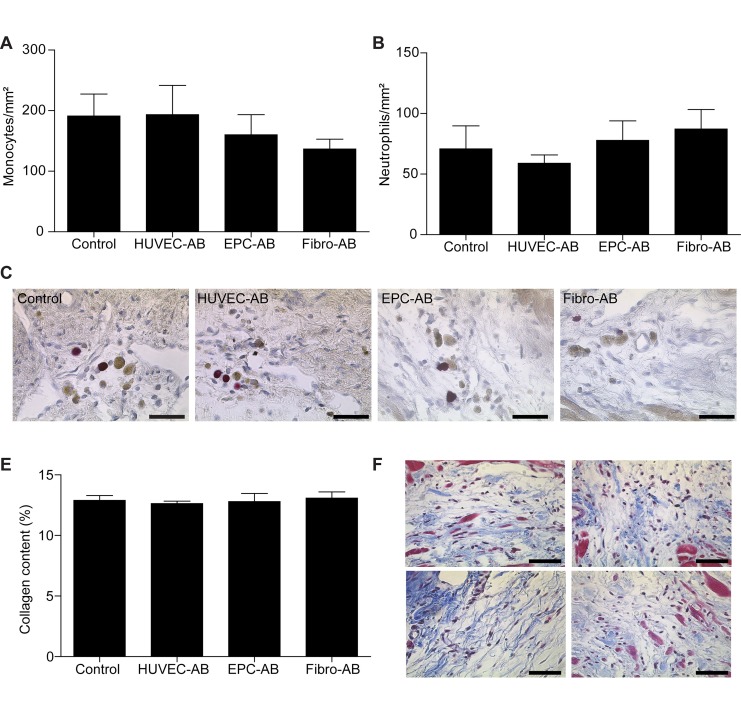
Analysis of inflammatory reaction in the infarcted areaThe transplantation of apoptotic bodies does not induce significant changes in the monocytes (A, C - brown) and in neutrophils quantification (B, C - red) between the experimental groups. Representative pictures from infarction areas are shown (C, Scale bar 25µm). Collagen content showed no differences between the groups (D). Representative sections of Gomori staining are shown (E, collagen blue, Scale bar 25 µm).